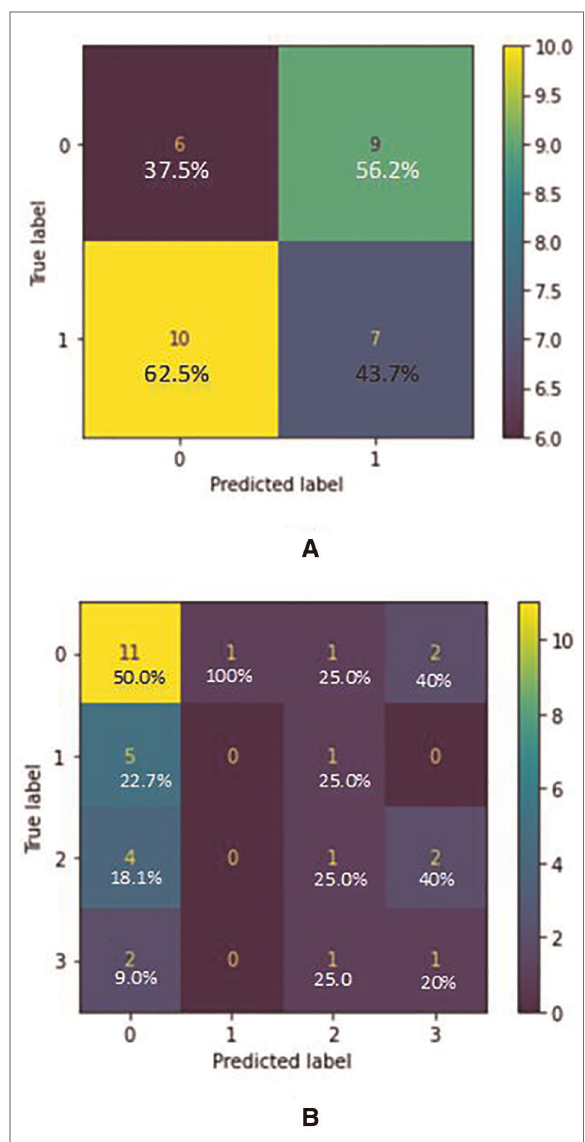
FIGURE 3 ( A ) confusion matrix for AD/CN classi fi cation (true label VS predicted label) - random forest classi fi er (acoustic features) where label 0 indicated “ cn ” and label 1 indicated “ ad ” . ( B ) Confusion matrix